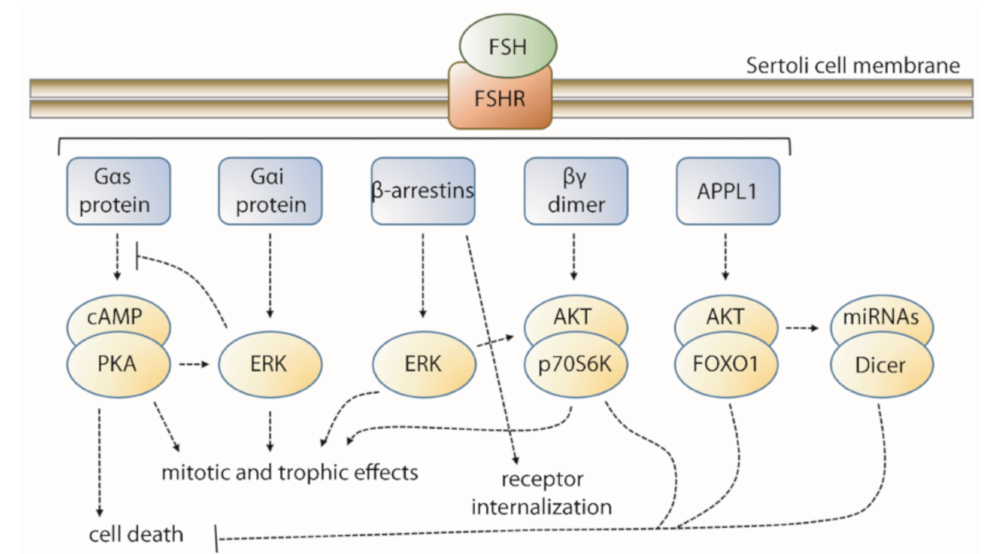
Figure 1. Main follicle-stimulating hormone (FSH)-mediated signaling network in Sertoli cells. Intracellular FSH receptor (FSHR) interactors are indicated in blue and associated with the downstream signaling modules. Most of the signaling cascades culminate with mitotic and trophic e ff ects in Sertoli cells, while other signals are addressed to anti-apoptotic e ff ects and β -arrestin-mediated FSHR